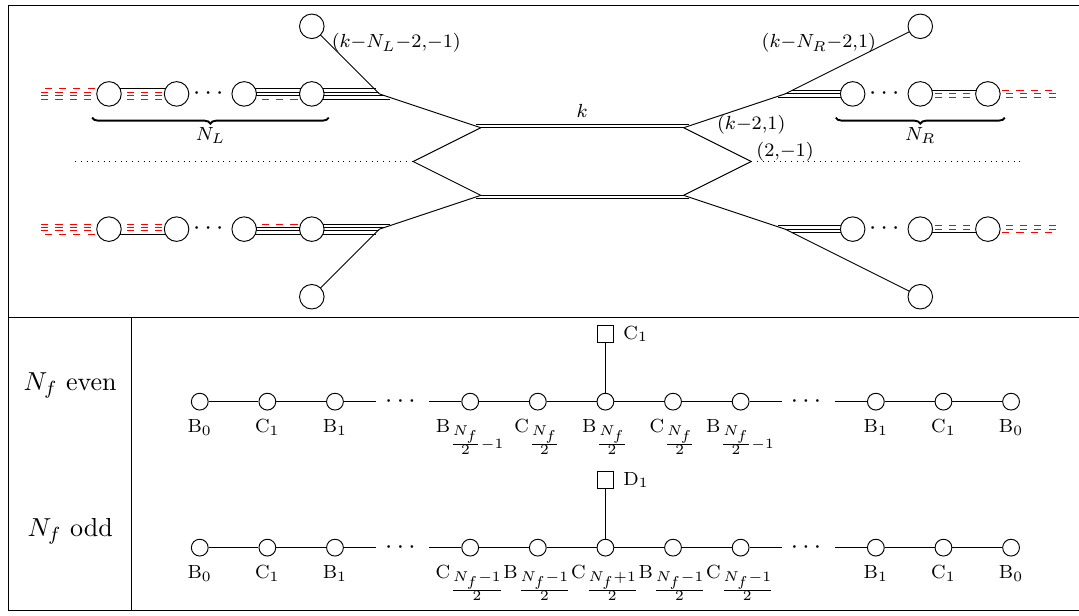
Table 9 . Brane web for O(2 k ) with N f = N L + N R (cid:13)avours. On a generic point of the Higgs branch O(2 k ) with N f (cid:13)avours is broken to pure O(2 k describe then a moduli space of quaternionic dimension 1